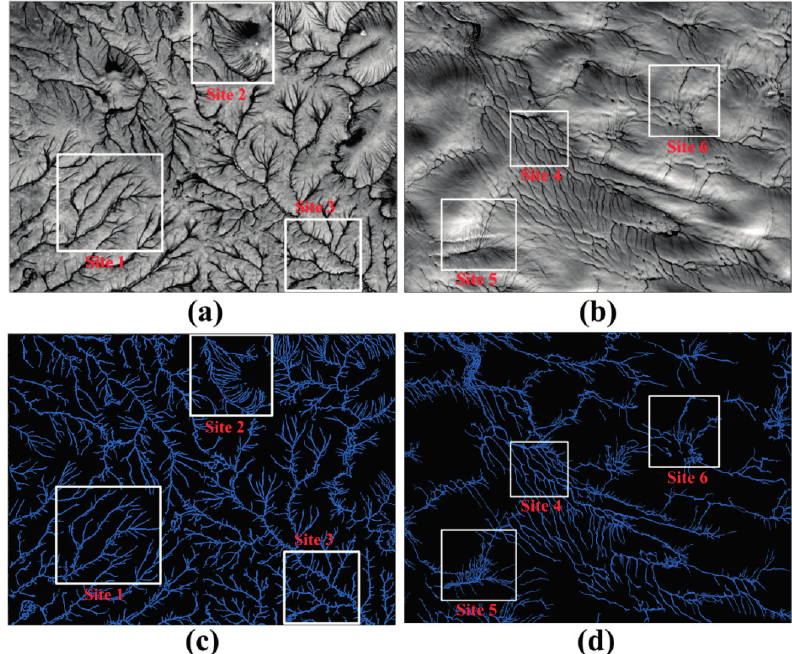
Figure 10. Landsat 8 OLI panchromatic images for the study area of ( a ) the Yukon Basin and ( b ) the Greenland Ice Sheet ablation zone. The river detection results using the proposed method are shown in ( c ) and ( d ). The six small sites selected to test the performance of the proposed method are indicated by the white